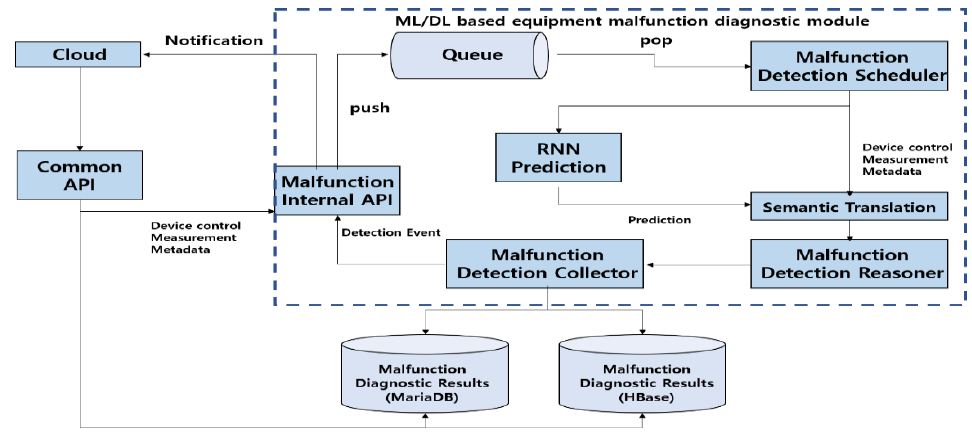
Figure 5. Integration architecture of a malfunction detection system for ventilation in poultry farms.